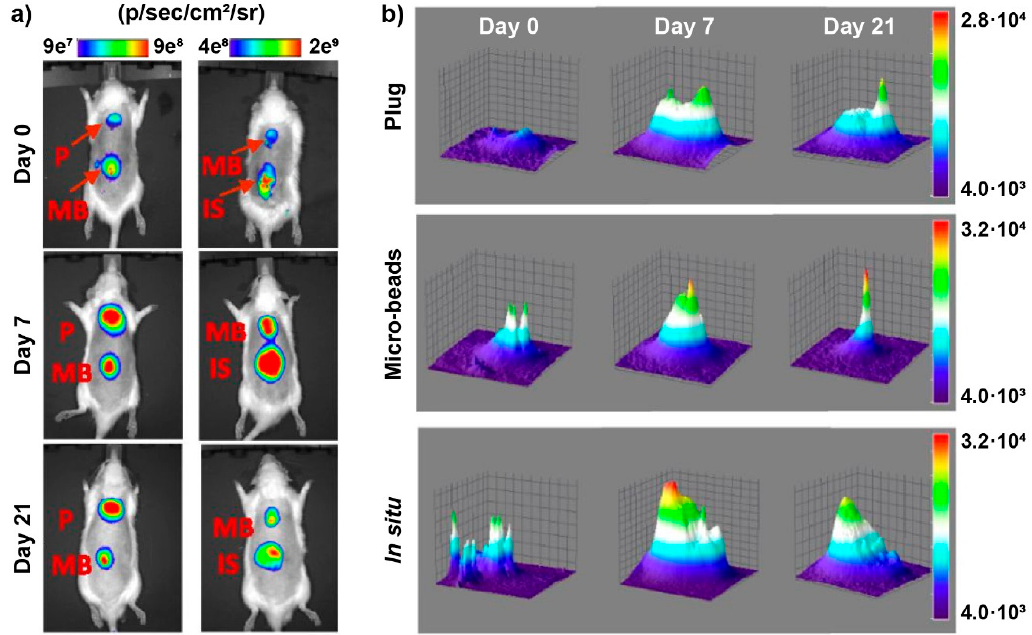
Figure 20. In vivo fluorescence analysis of hydrogels, with Xenogen IVIS ‐ 200: ( a ) whole ‐ animal images of the implanted plugs (P), microbeads (MB), and in situ polymerized (IS) hydrogels and ( b ) representative 3D plots of the fluorescence signal distribution and intensity. Data registered 0, 7, and 21 days post ‐ implantation. Figure adapted with permission from [124].